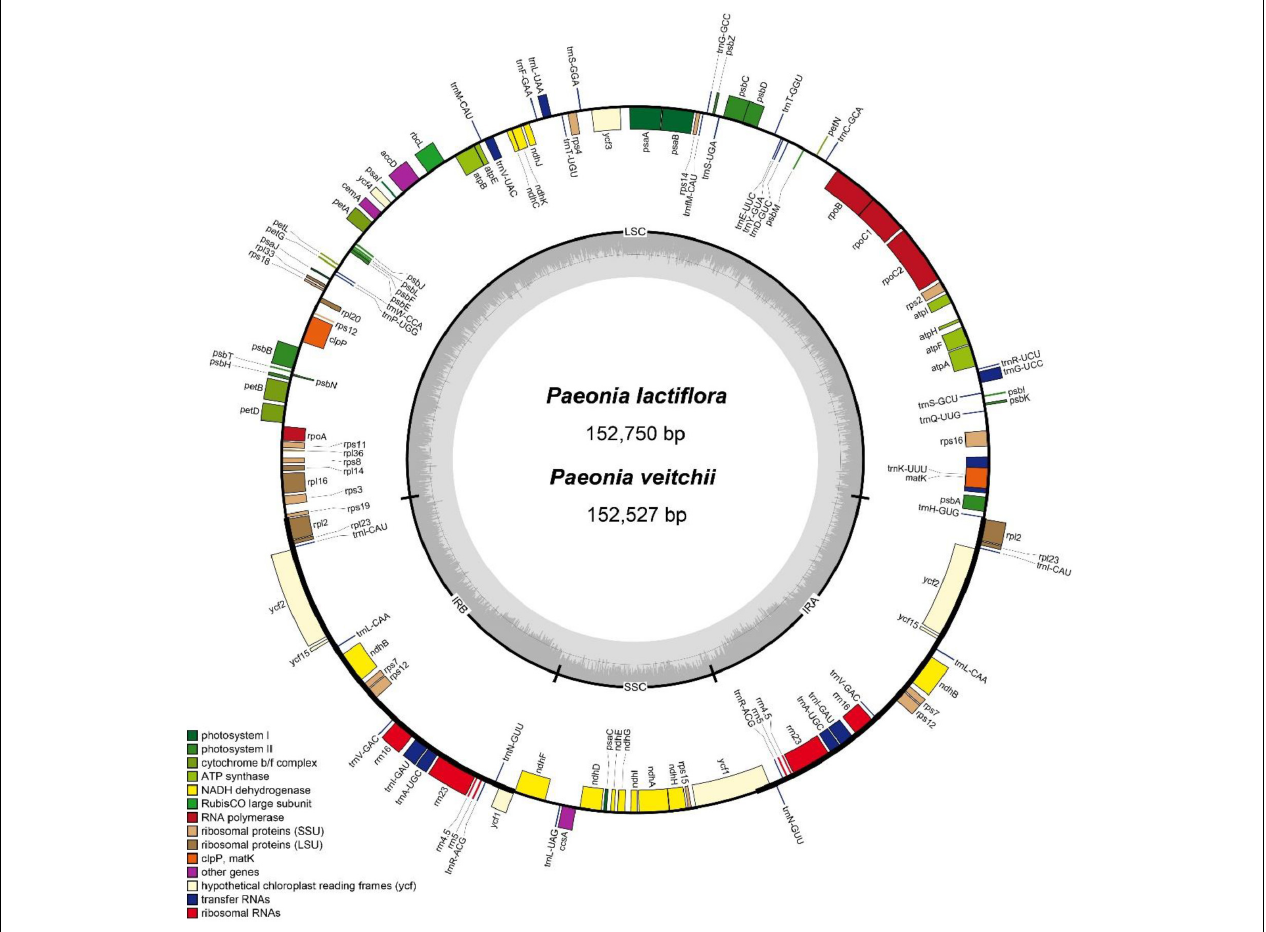
FIGURE 1 | Gene map of the complete chloroplast genomes of Paeonia lactiflora and Paeonia veitchii in this study. Genes on the inside of the circle are transcribed clockwise, whereas those outside are transcribed counter-clockwise. The darker and lighter gray in the inner circle corresponds to GC content and AT content respectively.